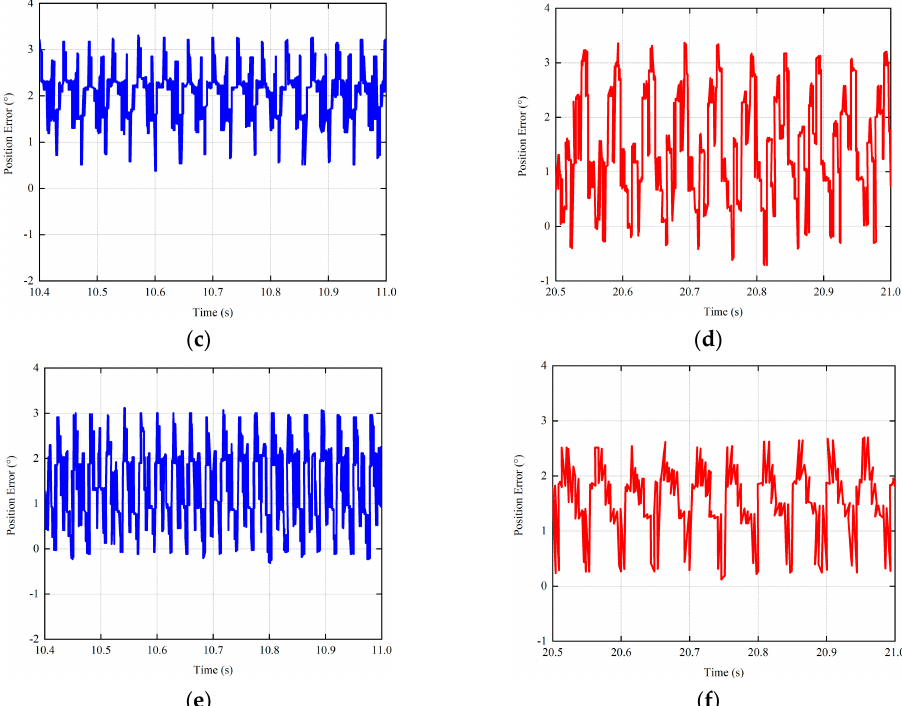
Figure 14. Rotor position error. ( a ) Rotor position error based on 1000 rpm and no load operation; ( b ) rotor position error based on 1000 rpm and 0.4 N · m load operation; ( c ) rotor position error based on 2000 rpm and no load operation; ( d ) rotor position error based on 2000 rpm and 0.4 N · m load operation; ( e ) rotor position error based on 3000 rpm and 0.4 N · m load operation; ( f ) rotor position error based on 3000 rpm and 0.4 N · m load